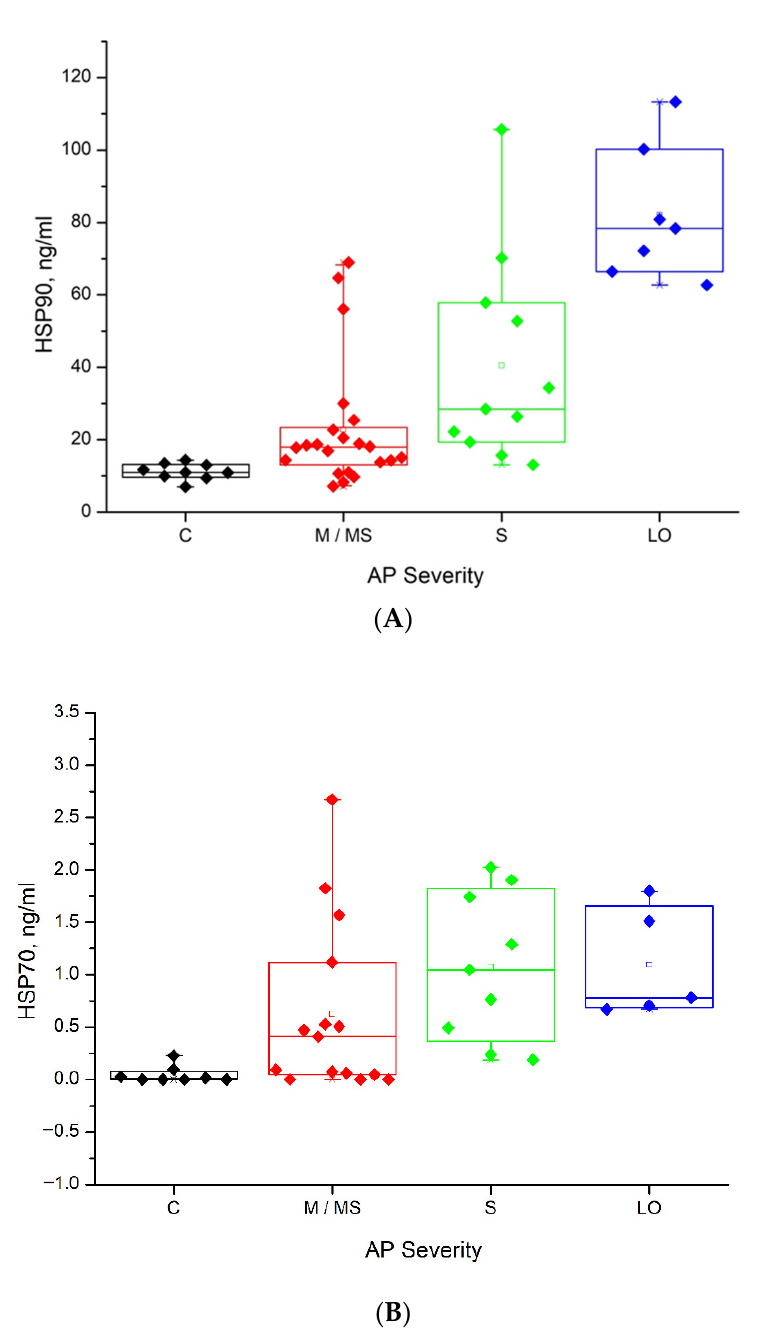
Figure 3. Concentrations of serum HSP90 vs. severity of AP: ( A ) p = 0.01 and HSP70; ( B ) p = 0.02